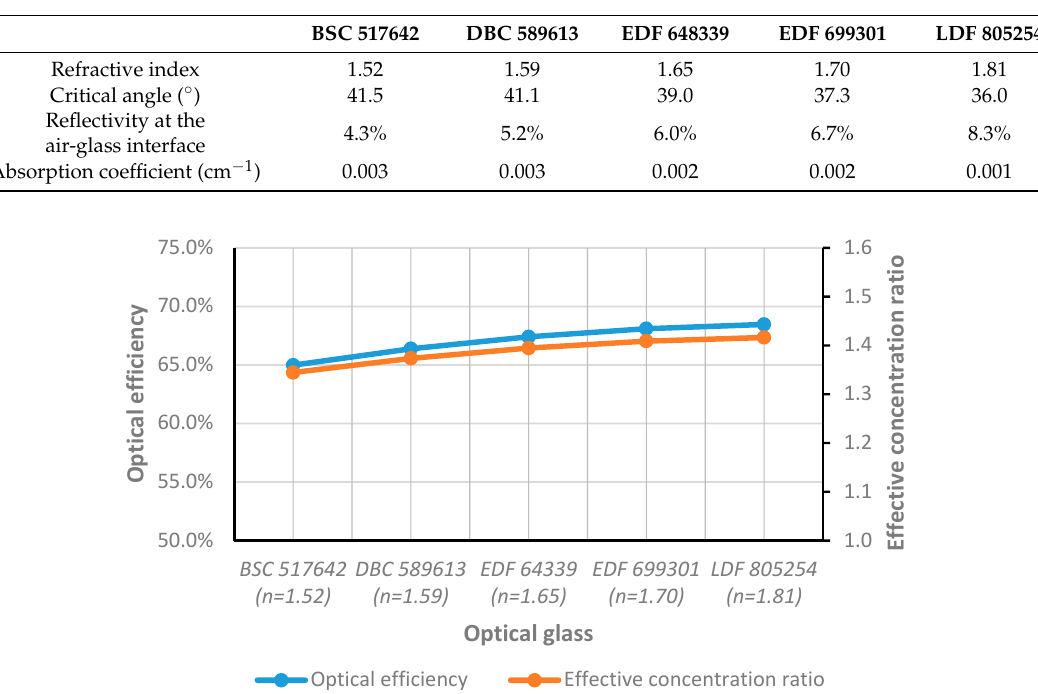
Figure 6. Optical efficiencies and effective concentration ratios of the systems with different optical glasses.